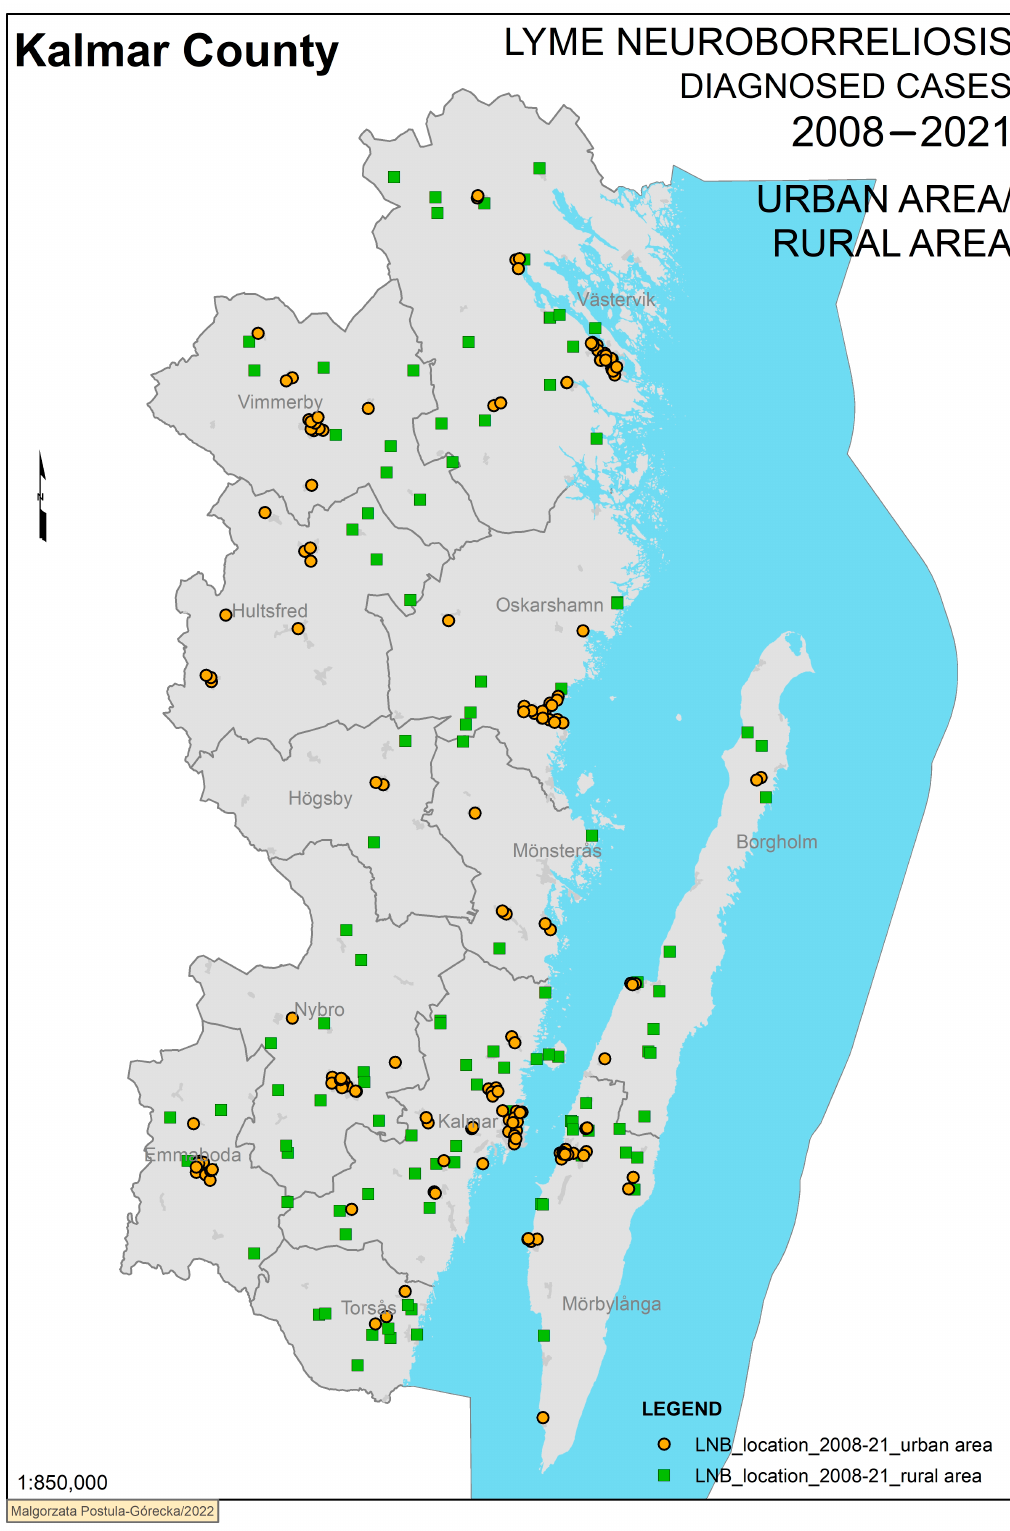
Figure 3. Confirmed Lyme neuroborreliosis cases grouped according to urban or rural area status. Figure 3. Definite Lyme neuroborreliosis cases in Kalmar County 2008–2021 grouped by living in urban or rural areas, with 162 cases in urban areas and 110 in rural areas. The municipalities within Kalmar County are shown in